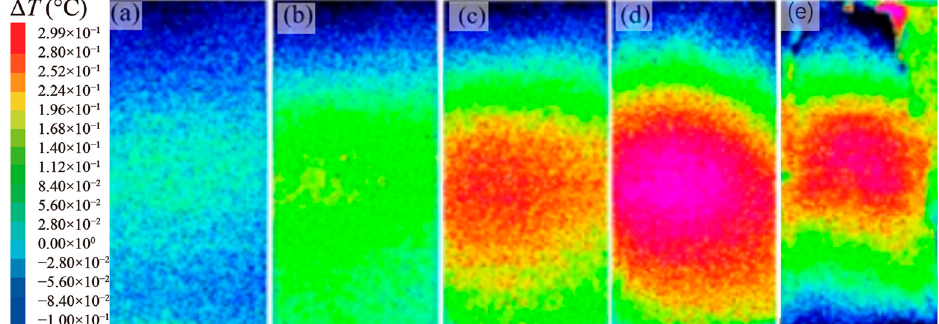
Figure 2. Infrared radiation image of a marble specimen subjected to uniaxial compression experiment at different stress levels ( a ) 0.1 σ c ; ( b ) 0.4 σ c ; ( c ) 0.8 σ c ; ( d ) σ c ; ( e ) 0.1 σ c [52].